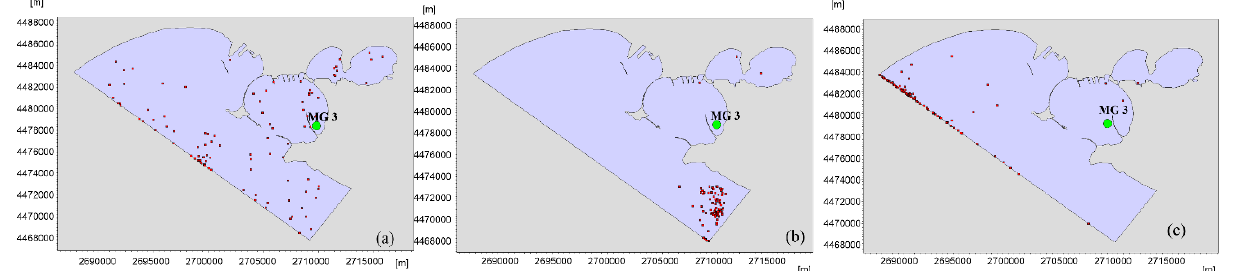
Figure 14. Percentage PT3 (MG3) — the cloud of particles: ( a ) 30 days after release; ( b ) 60 days after release; ( c ) 90 days after release at surface layer.